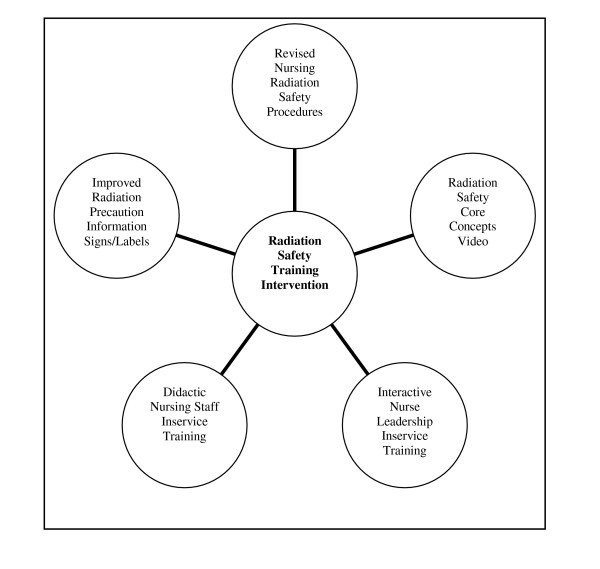
Elements of the MSKCC radiation safety training intervention for oncology nurses.